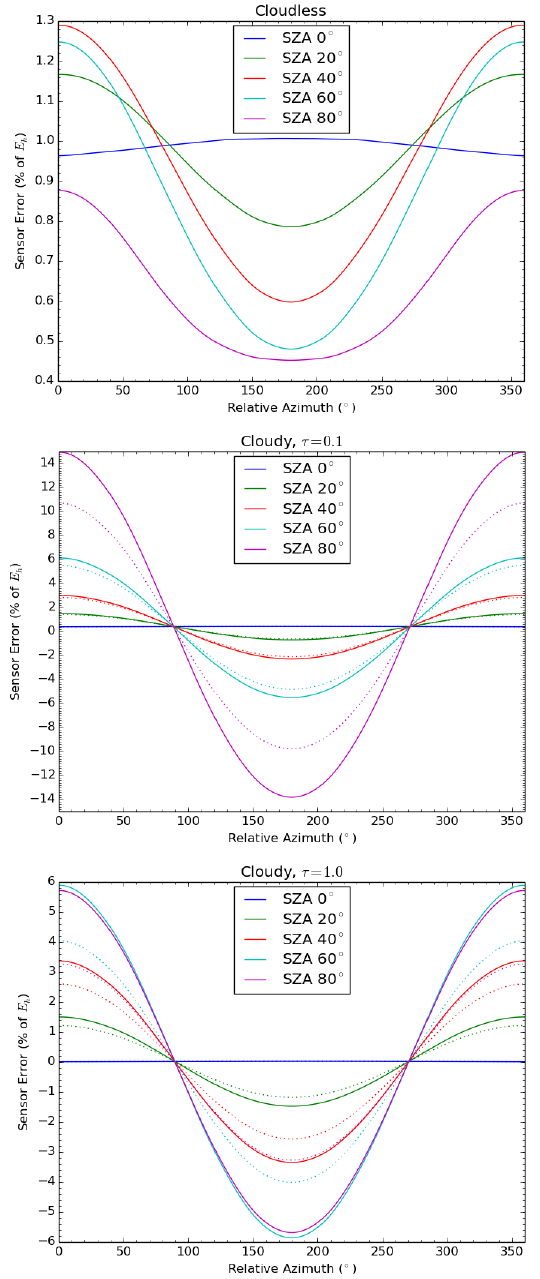
Figure 1. Simulated error in global diffuse irradiance, η dif , for a cosine-response irradiance sensor tilted 3 ◦ . One cloudless (top) and two cloudy cases are shown. In the middle and bottom plots, solid (dotted) lines denote liquid (ice) water cloud results. Note dif- ferent scale on y